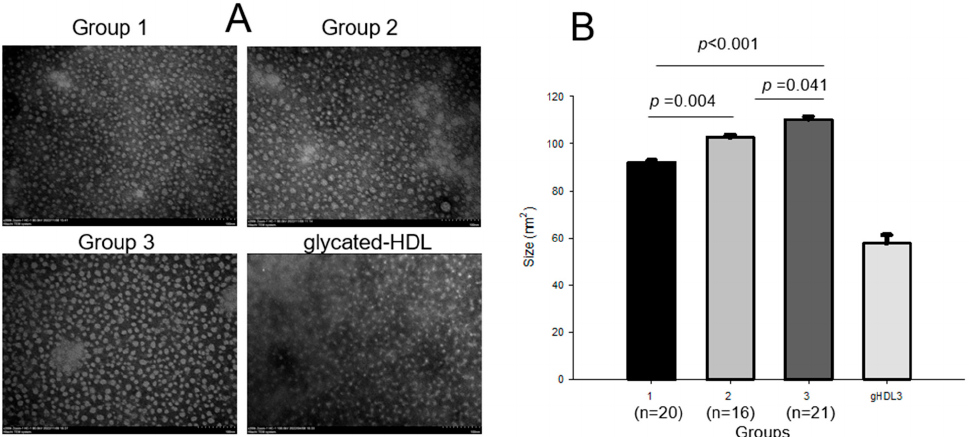
Figure 4. Transmission electron microscopy (TEM) images and area analysis of HDL 3 from each group ( A ) and comparison of particle sizes ( B ). gHDL 3 , glycated HDL 3 . group ( A ) and comparison of particle sizes ( B ). gHDL 3 , glycated HDL 3